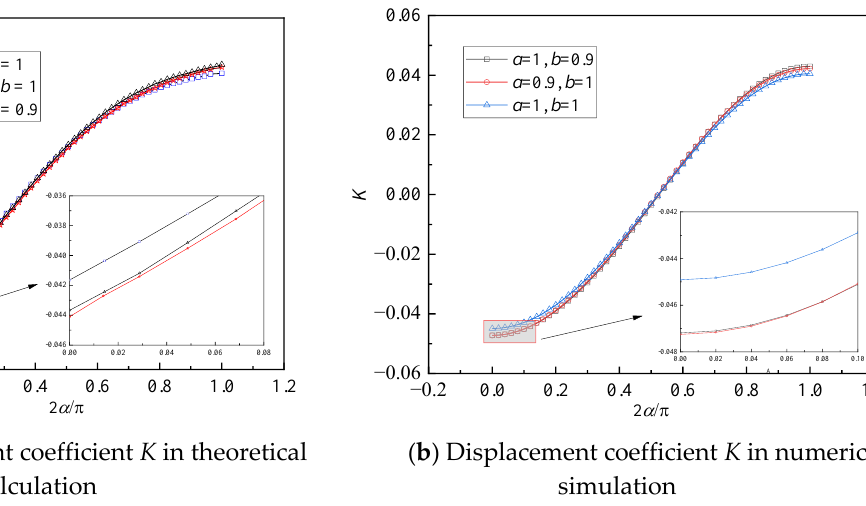
Figure 15. Comparison of radial displacement calculation results of functionally graded lining with different elastic modulus parameters under the condition of elastic modulus Function Ⅰ .